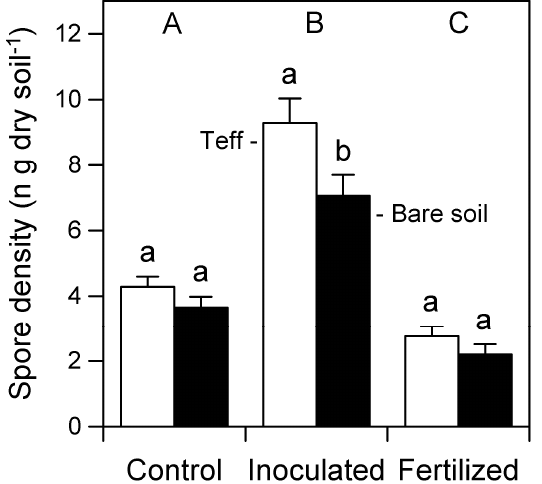
Figure 2. Density of arbuscular mycorrhizal fungal (AMF) spores (n per g dry soil − 1 ) in cropland soil (Control), cropland soil inoculated with forest soil (Inoculated) and N-P fertilisation (Fertilized) with Eragrostis tef plants (open bars) and without plants (i.e., bare soil; filled bars). Different capital letters indicate significant differences between treatments (two-way ANOVA, p < 0.05) while different small letters indicate significant differences between pots with teff or bare soil within the same treatment (TukeyHSD, p < 0.05); values are the average of three soil types of five replicates each (n = 15; mean + SE).